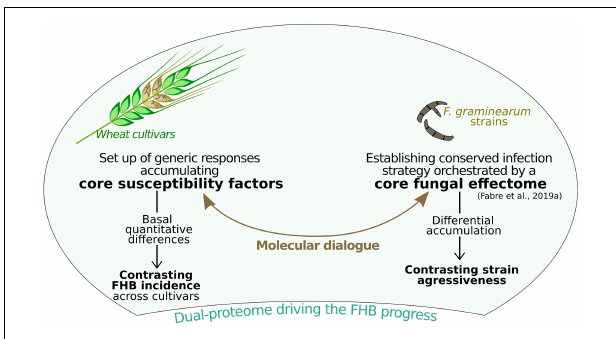
FIGURE 8 | Working model summarizing the core dual proteome hypothesis between wheat and Fusarium graminearum . Wheat spike was obtained from